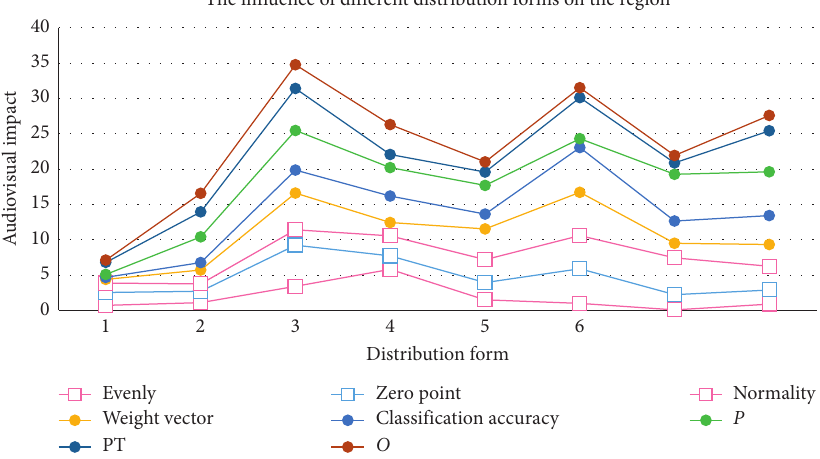
Figure 1: The influence of different distribution forms on the